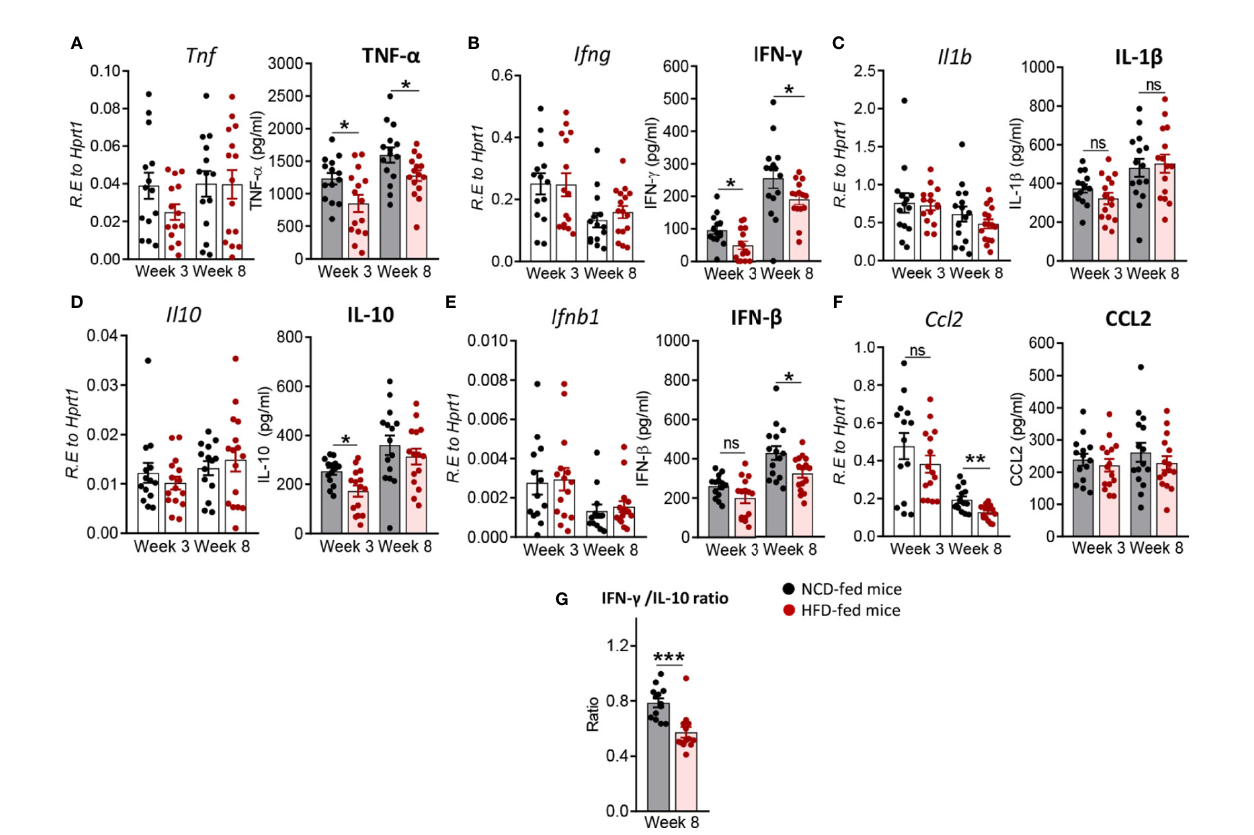
FIGURE 3 | Pre-diabetes alters cytokine production in Mtb-infected lungs. Cytokine mRNA and protein levels were determined in lung homogenates by qRT- PCR and ELISA. Lung mRNA expression and protein concentrations of (A) Tnf , TNF- a ; (B) Ifng , IFN- g ; (C) Il1b , IL-1 b ; (D) Il10 , IL-10; (E) Ifnb1 , IFN- b and (F) Ccl2 , CCL2 from NCD- and HFD fed-mice at 3-and-8 weeks p.i. (G) IFN- g /IL-10 ratio was determined for each mouse at week 8. Data are means ± SEM of n=13-15 mice/group analyzed cumulatively across two independent experiments. Data analysis was performed by Mann-Whitney U test. ns = not signi fi cant, *p < 0.05, and ***p <